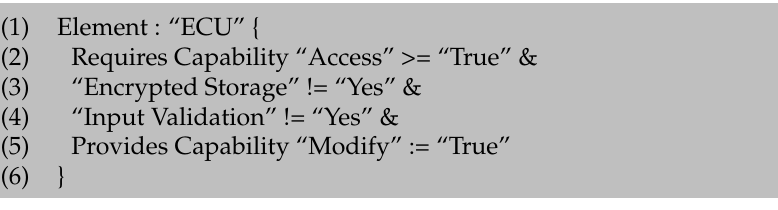
Figure A2. Anti-Pattern for Rule 2.